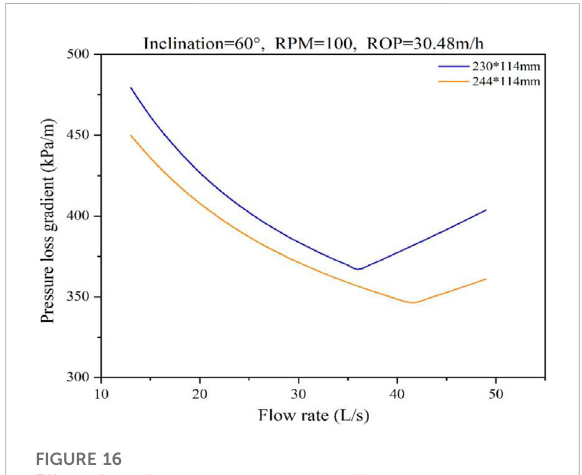
FIGURE 14 Effect of the inclination angle on pressure loss.